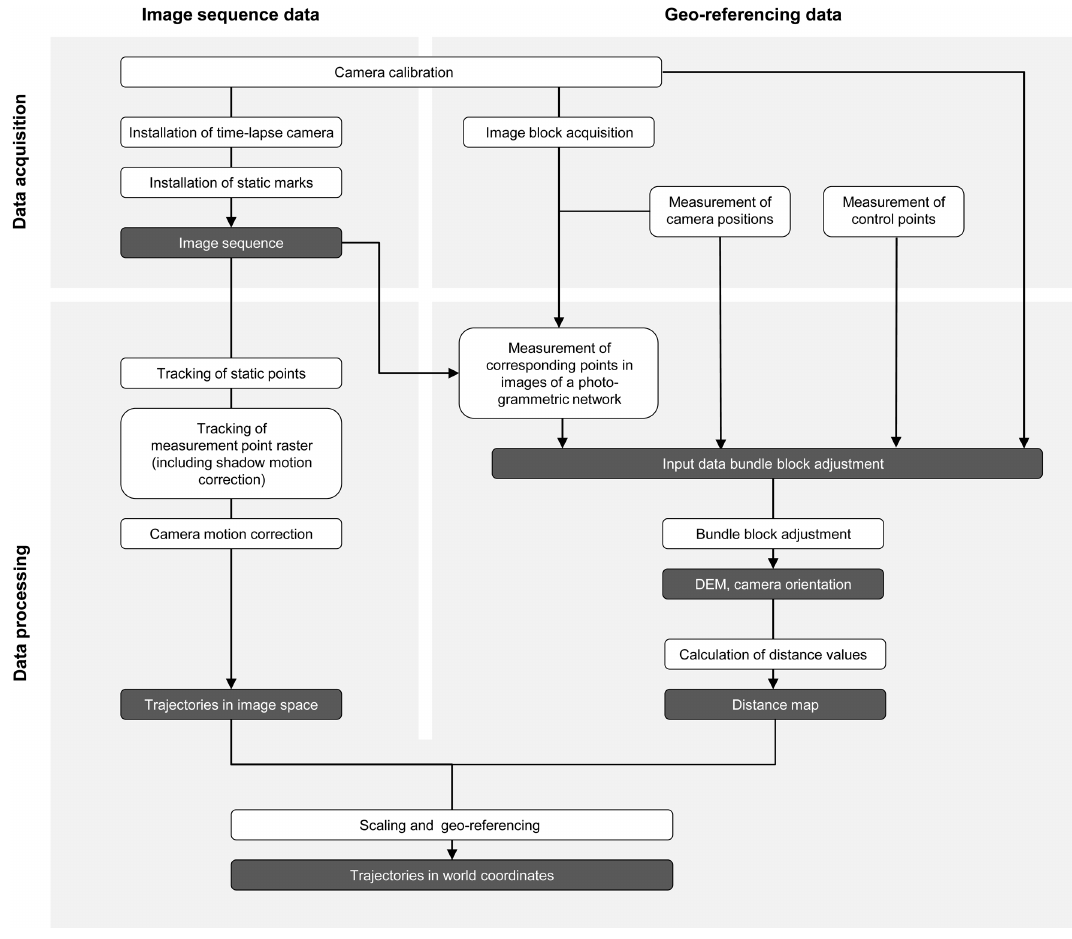
Figure 2. Workflow of monoscopic image sequence measurement.